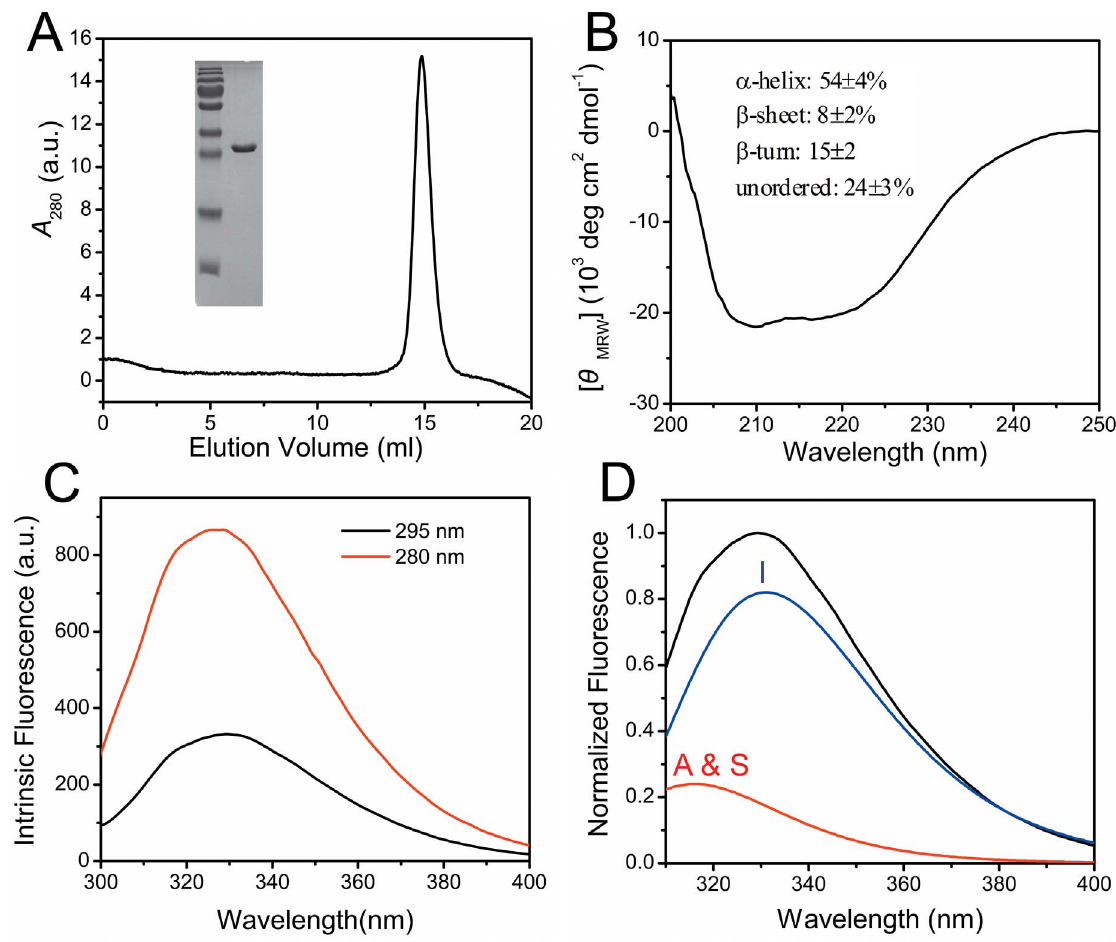
Figure 3. Biophysical characterization of the recombinant CrCaf1. (A) SEC analysis. The inset shows the identification of the recombinant proteins by SDS-PAGE. (B) CD spectrum and the percentages of various secondary structure components. (C) Intrinsic fluorescence of CrCaf1 with an excitation wavelength of 280 nm or 295 nm. (D) Fitting of the Trp fluorescence spectrum obtained by exciting at 295 nm by the theoretical model of discrete states of Trp fluorophores in proteins. The samples for the biophysical experiments were prepared in buffer A with a final concentration of 0.2 mg/ml.